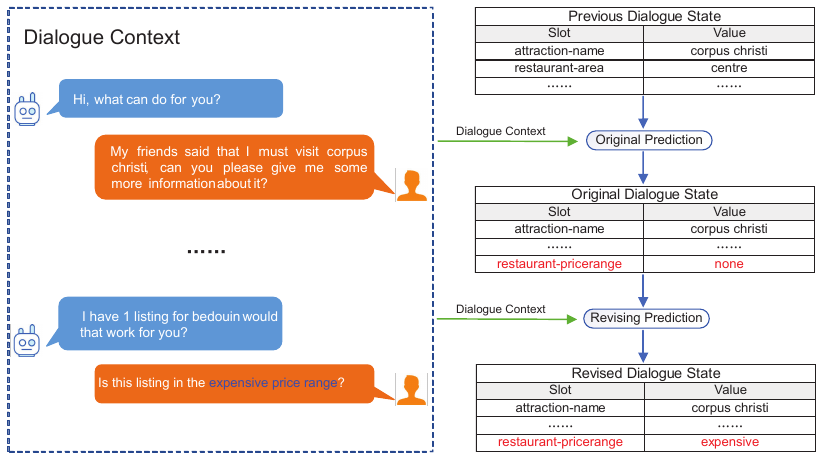
Figure 2. An example of a two-stage dialogue state prediction process of RSP-DST. The user wants to book an expensive restaurant by “Is this listing in the expensive price range”. In the two-stage dialogue state prediction process, the mistake of slot restaurant-pricerange existing in the original dialogue state is revised with the right value in the revising prediction